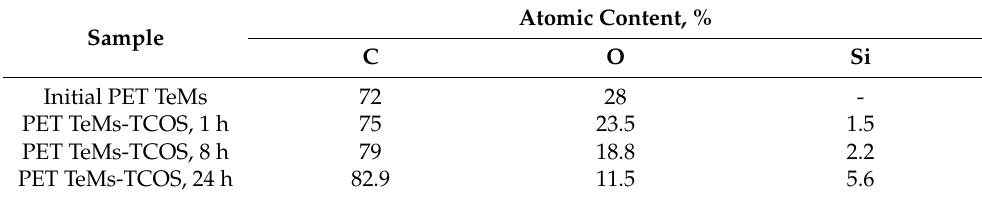
Figure 3. EDX mapping of elements and SEM picture of the surface of PET TeMs-TCOS modified at 15 mM and 24 h. Table 4. Atomic content calculated based on EDX